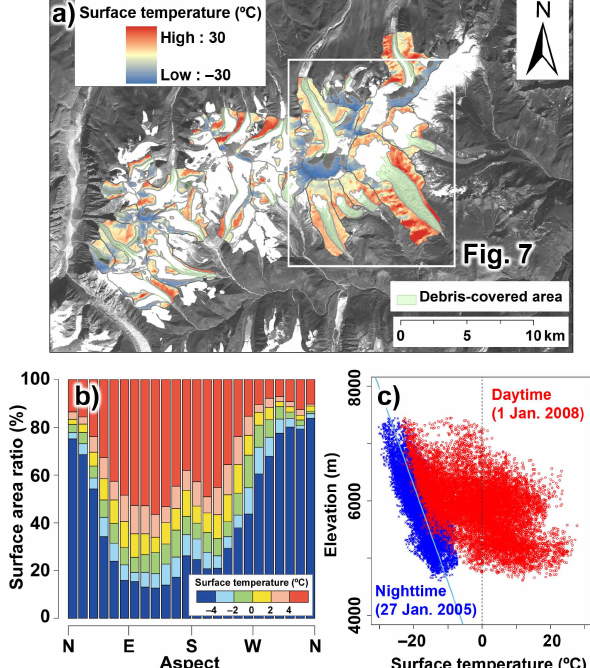
Fig. 4. (a) Spatial, (b) aspect, and (c) altitudinal distributions of surface temperature on potential debris-supply slopes in the Kulha Kangri Massif region on 1 January 2008 (location indicated in Fig. 1). Background image is AVNIR-2. Aspect bin size in (b) is 10 ◦ . Nighttime temperature distribution on 27 January 2005 is also shown and conpared in (c)